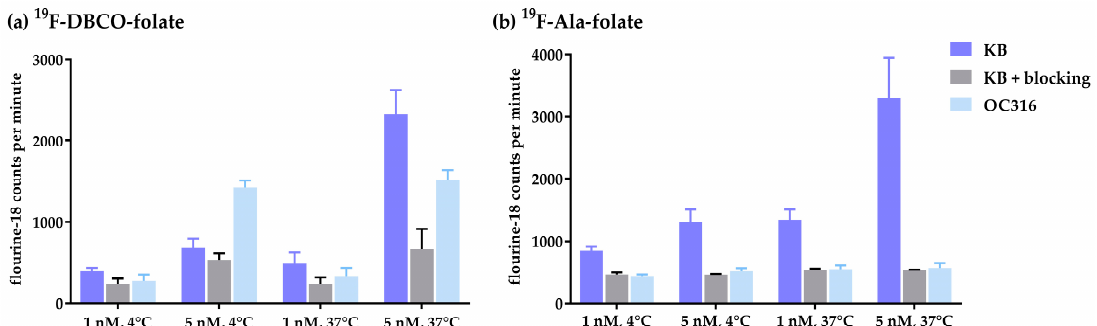
Figure 2. Internalization of 18 F-DBCO-folate ( a ) and 18 F-Ala-folate ( b ) in KB and OC316 cells at 4 ◦ C and 37 ◦ C for 1 h including blocking with native folic acid.